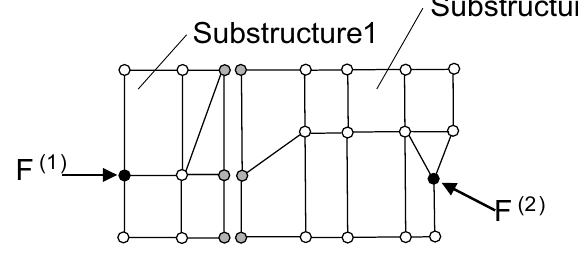
Fig. 1. Sketch of two substructures with marked interface degrees of freedom